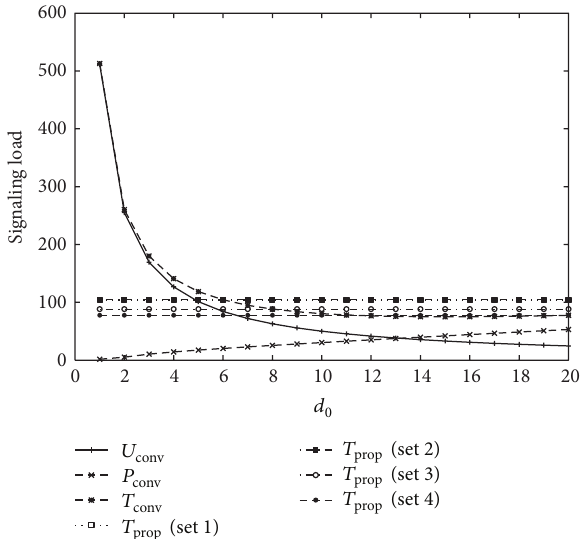
Figure 4: Signaling load for 1/𝜆 𝑐 = 10.5 ∗ 20/3600(ℎ) (low mobil- ity), 1/𝜆 = 10.5 ∗ 600/3600(ℎ) (long inter-session idle period).